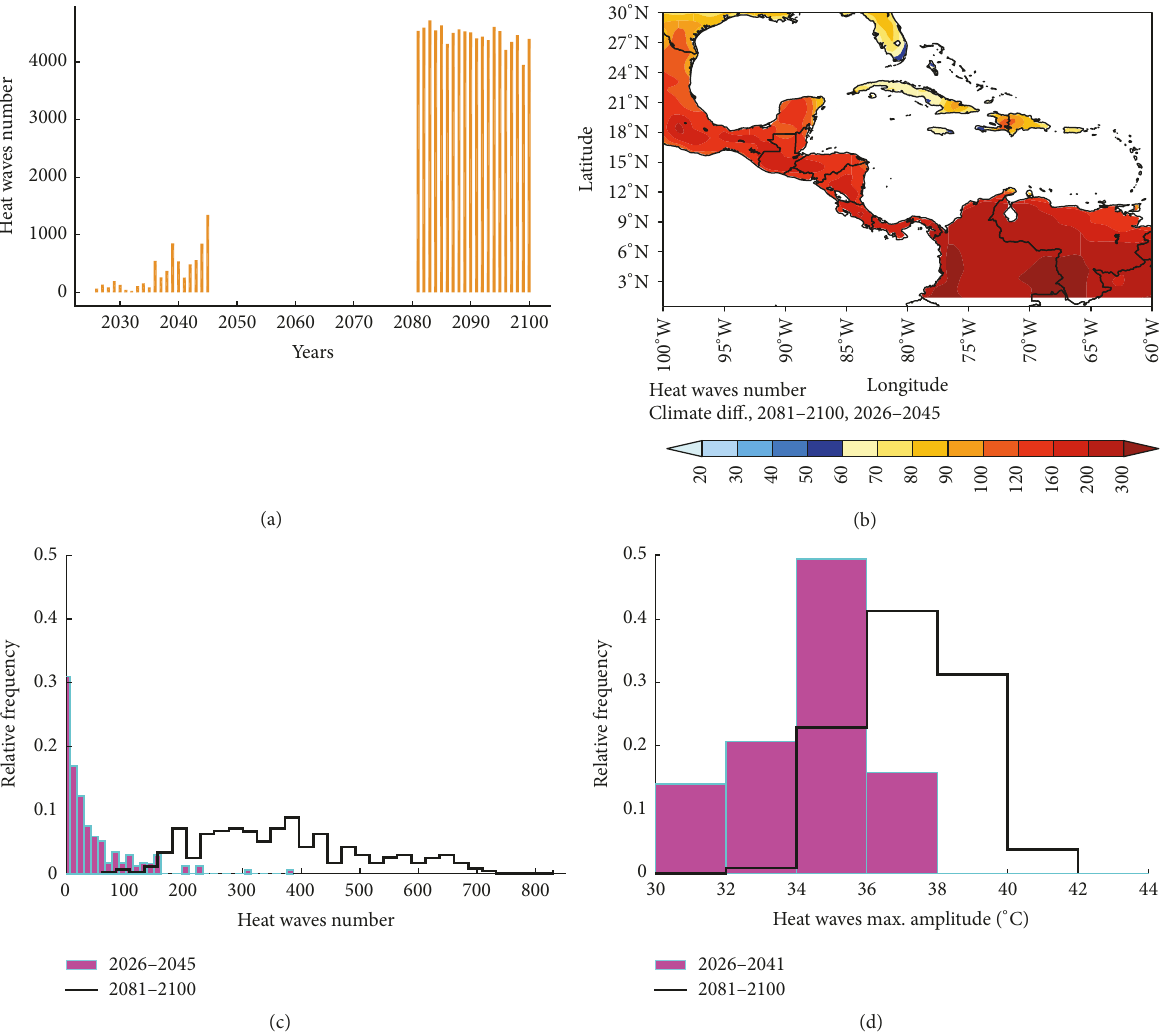
Figure 9: Multimodel ensemble mean for the RCP8.5 scenario: (a) annual time series, (b) HWs number change between the climate periods 2081–2100 and 2026–2045, (c) HWs frequency of the whole region including the ocean area, and (d) regional average of HWs maximum